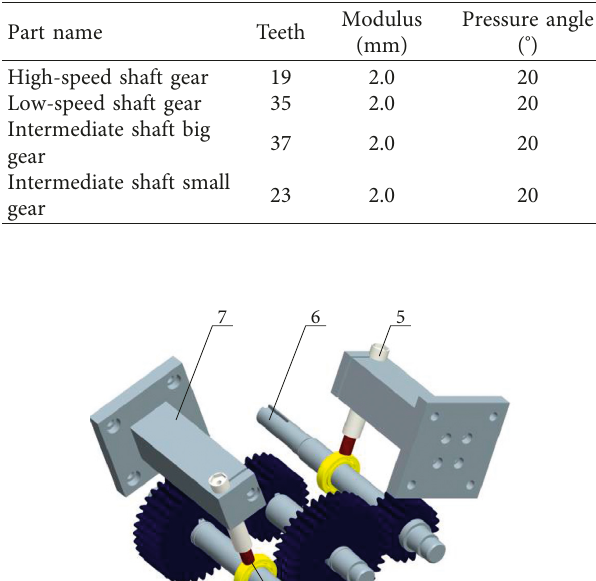
Figure 1: Gear drive active control system with a built-in piezo- electric actuator. (1) Bracket. (2) Adjustable speed motor. (3) Gearbox. (4) Piezoelectric actuator. (5) Coupling. (6) Magnetic powder brake. (7) Gearbox base. Table 1: Gear parameters at all levels.